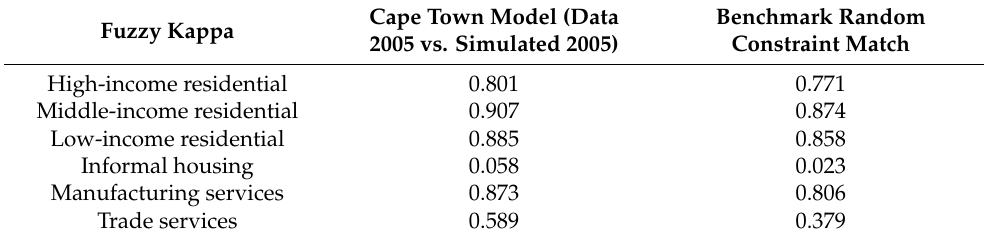
Table 2. Results from the calibration and validation of the land use model.